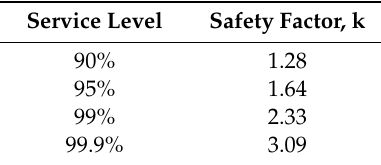
Table A1. Safety factor, k; service level (own elaboration based on